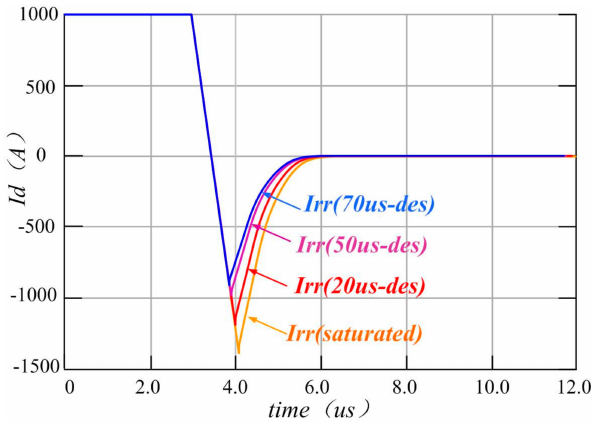
Figure 6. The influence of gate desaturation control on the reverse recovery current of the RC-IGBT